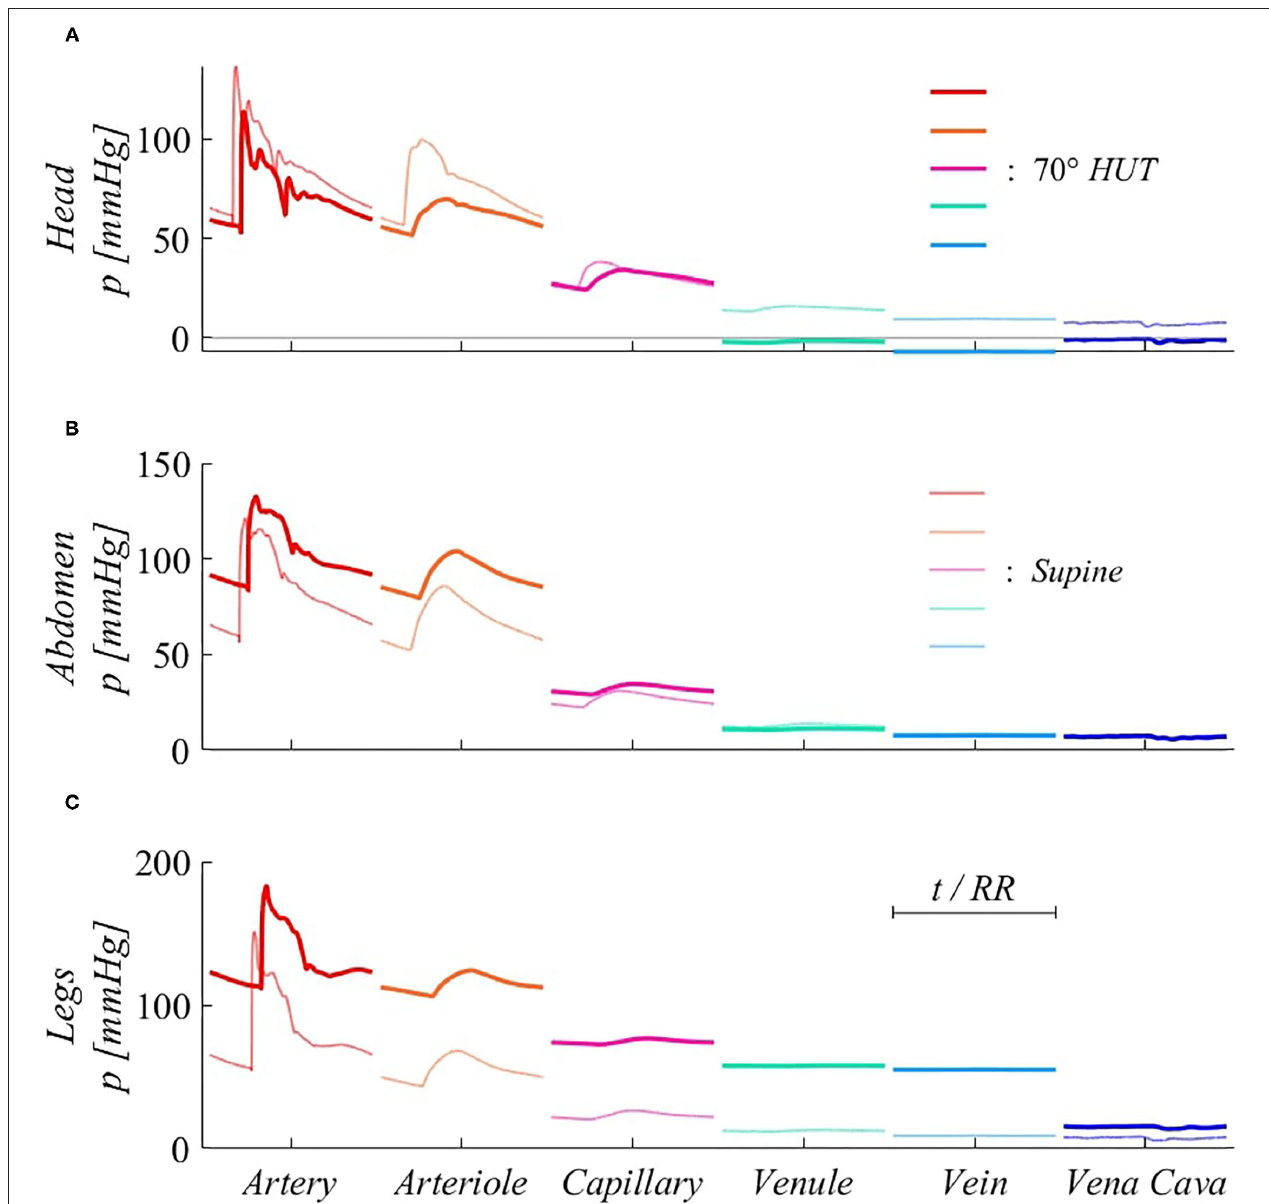
FIGURE 7 | Steady-state pressure signals at supine (thin, light colored lines) and 70 ◦ HUT (thick, dark colored lines) for the 0D side of the systemic circulation, from terminal arteries to venae cavae 0D compartments. Panels refer to different body regions: (A) head (artery #13), compartmental midpoint at z = − 0.15 m; (B) abdomen (artery #34), compartmental midpoint at z = + 0.15 m, (C) legs (artery #45), compartmental midpoint at z = + 0.72 m (distances are measured from the right atrium position along the longitudinal body axis z